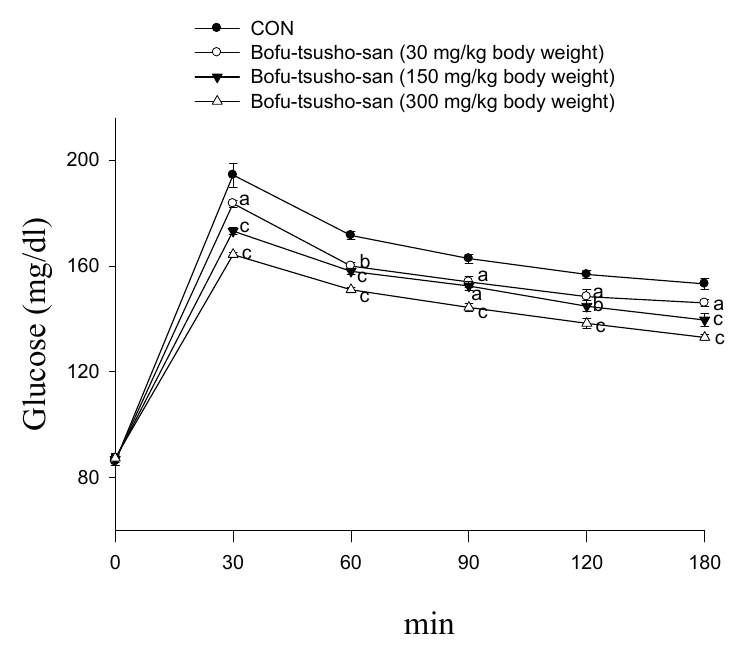
Figure 1. Effects of extract granules of Bofu-tsusho-san (BO) on oral glucose tolerance in ICR normal mice. Animals in all groups received oral glucose 30 min after the extract administration. Blood samples were collected and centrifuged at 3000 rpm for 10